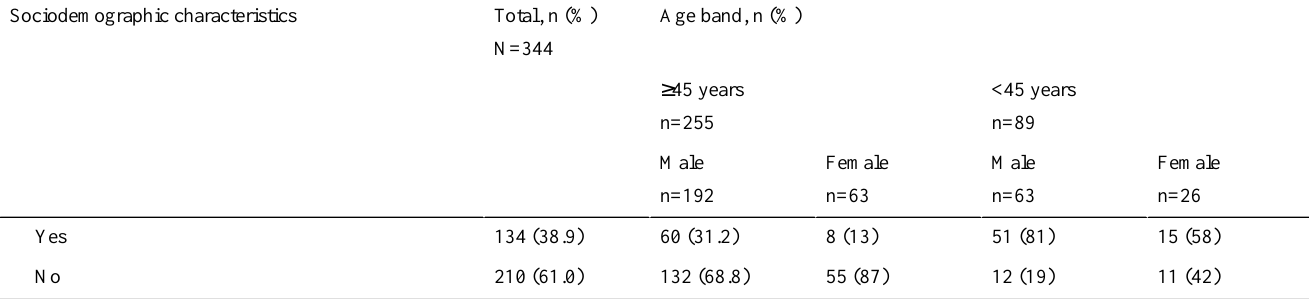
(Table 2). The majority of online health-related information seekers (76/96, 79%) reported that their main source of information was still their physician. However, only 96 of 134 Internet users (71.6%) reported using the Internet for health-related information with a mean search frequency of 6.4